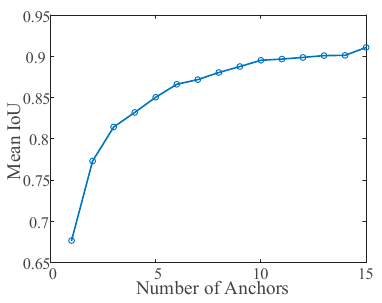
Figure 7. Number of anchor boxes and mean Intersection-over-Union (MIoU).